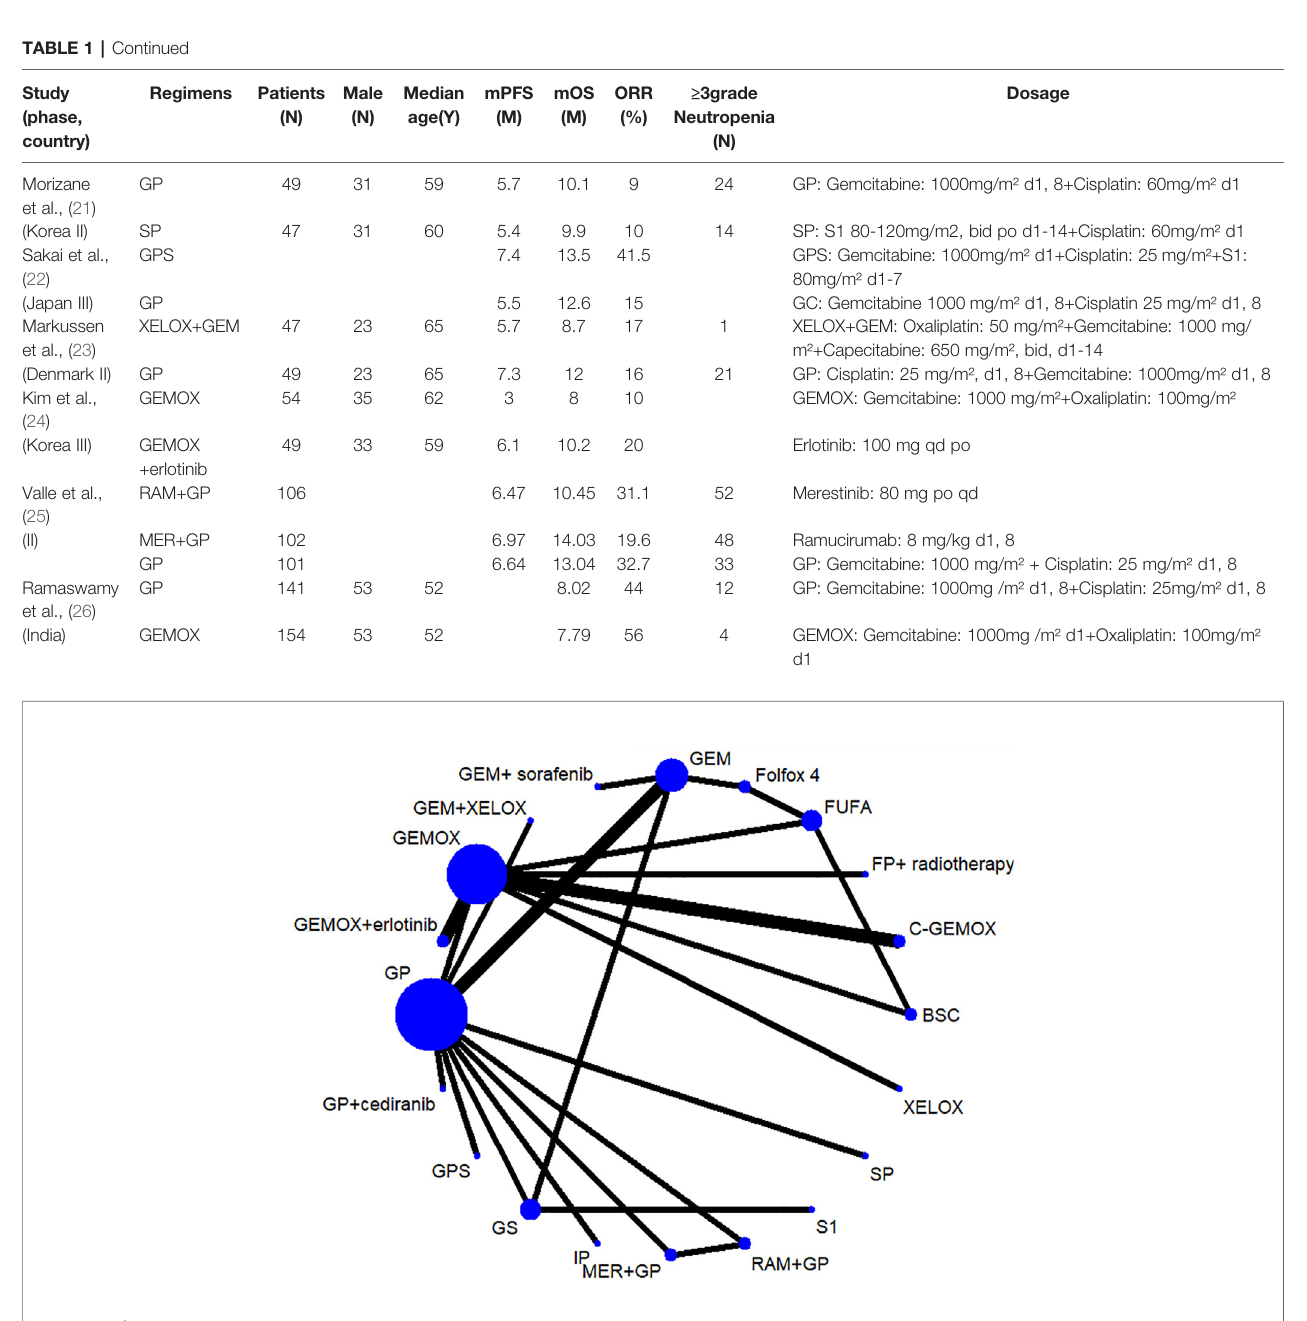
FIGURE 2 | Network evidence diagram of drugs in each